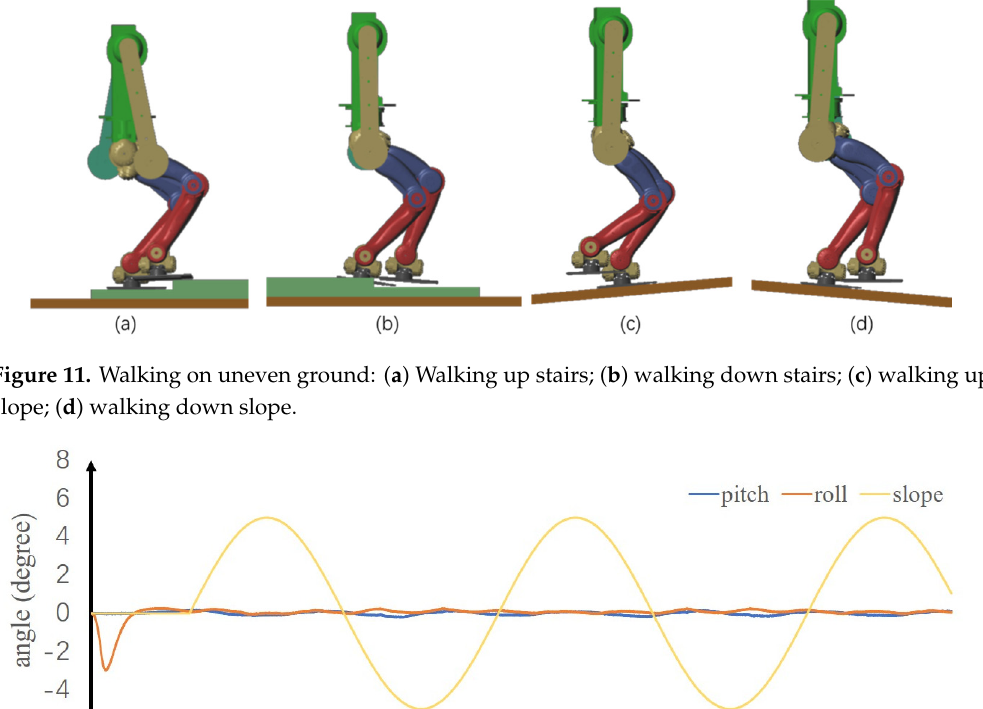
Figure 12. The angle of the body in the direction of pitch and roll while walking on the dynamic